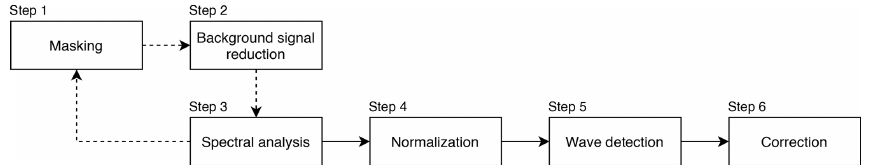
Figure 3. Steps of the wave detection algorithm TeRACWA (Terrestrial Radar Assessment of Calving Wave Activity). Steps linked by dashed and solid arrows are respectively applied to each TRI acquisition and to the resulting data